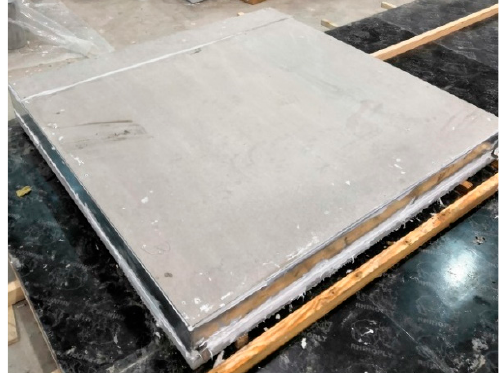
Figure 2. LAEWP specimen.